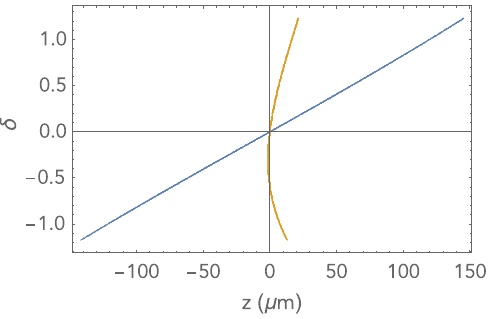
FIG. 17. Longitudinal phase space distribution at the entrance to the beam line (blue) and at the exit (orange), where the final bunch displays a linearly ramped current profile shown in Fig.